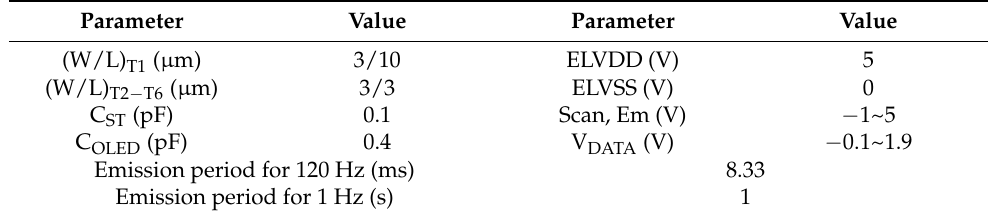
Figure 4. Measured and simulated ( a ) LTPS TFT and ( b ) a-IZTO TFT transfer curves. Table 1. Specifications of proposed 6T1C pixel